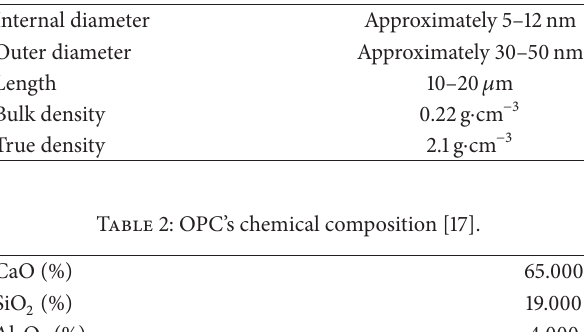
Table 1: Properties of carbon nanotubes.